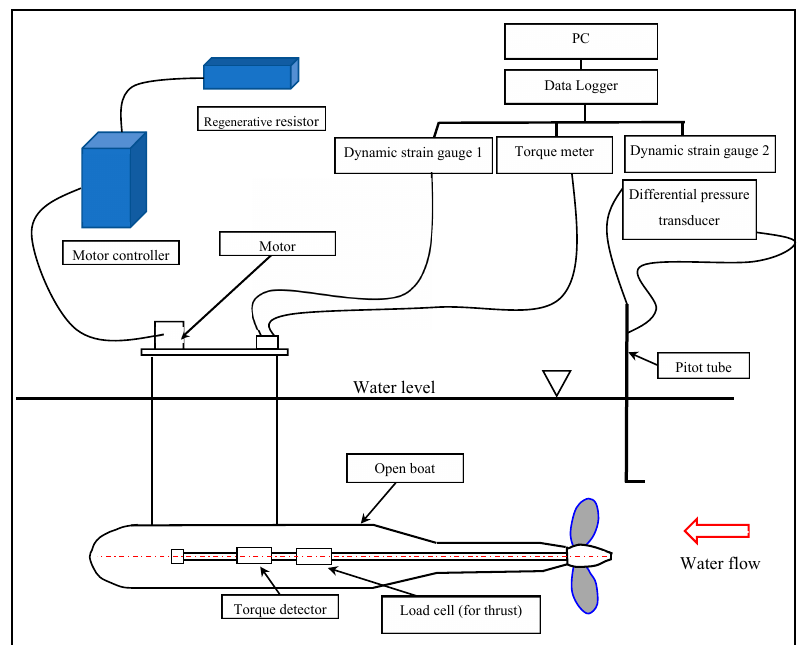
Figure 1. Schematic diagram of 0.35 m diameter test section at West Japan Fluid Engineering Laboratory Co., Ltd.